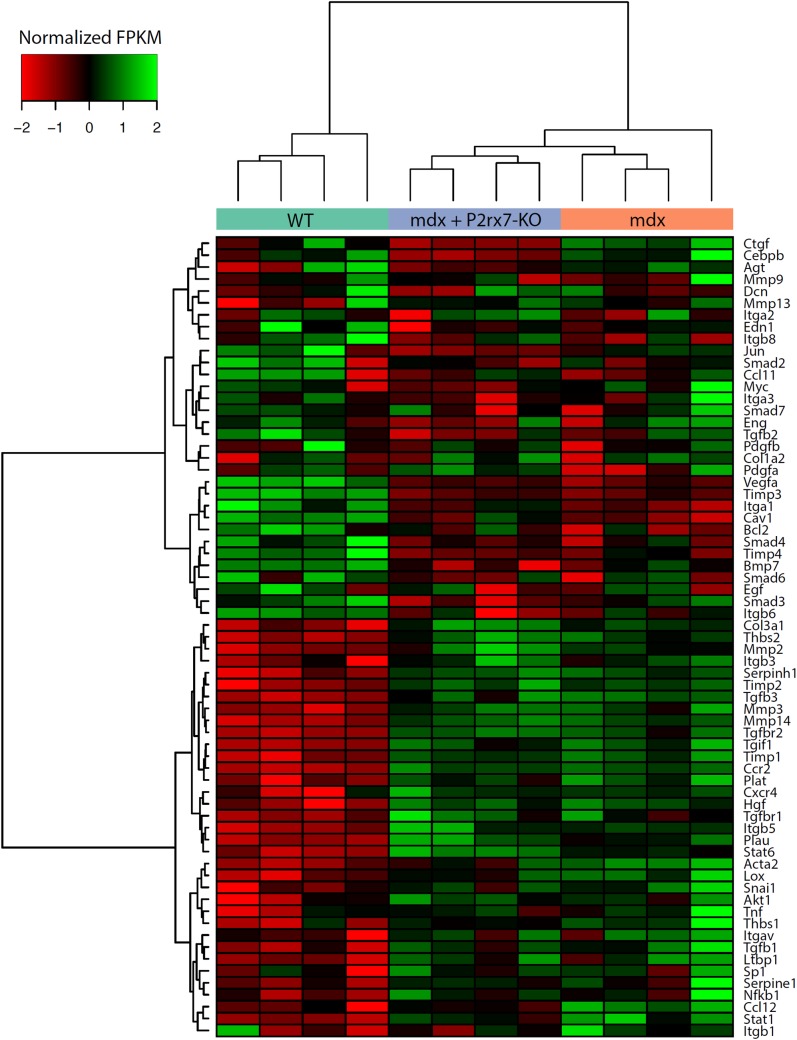
Expression of genes associated with fibrosis as measured by RNA-Seq.Fragments per kilobase per million fragments mapped (FPKM) values for each sample were obtained using Cuffnorm (Tuxedo suite), log-transformed, and normalized to zero mean and unit standard deviation (rows with missing expression values were removed). Hierarchical clustering was performed using the Ward’s method [42]. KO, knockout.